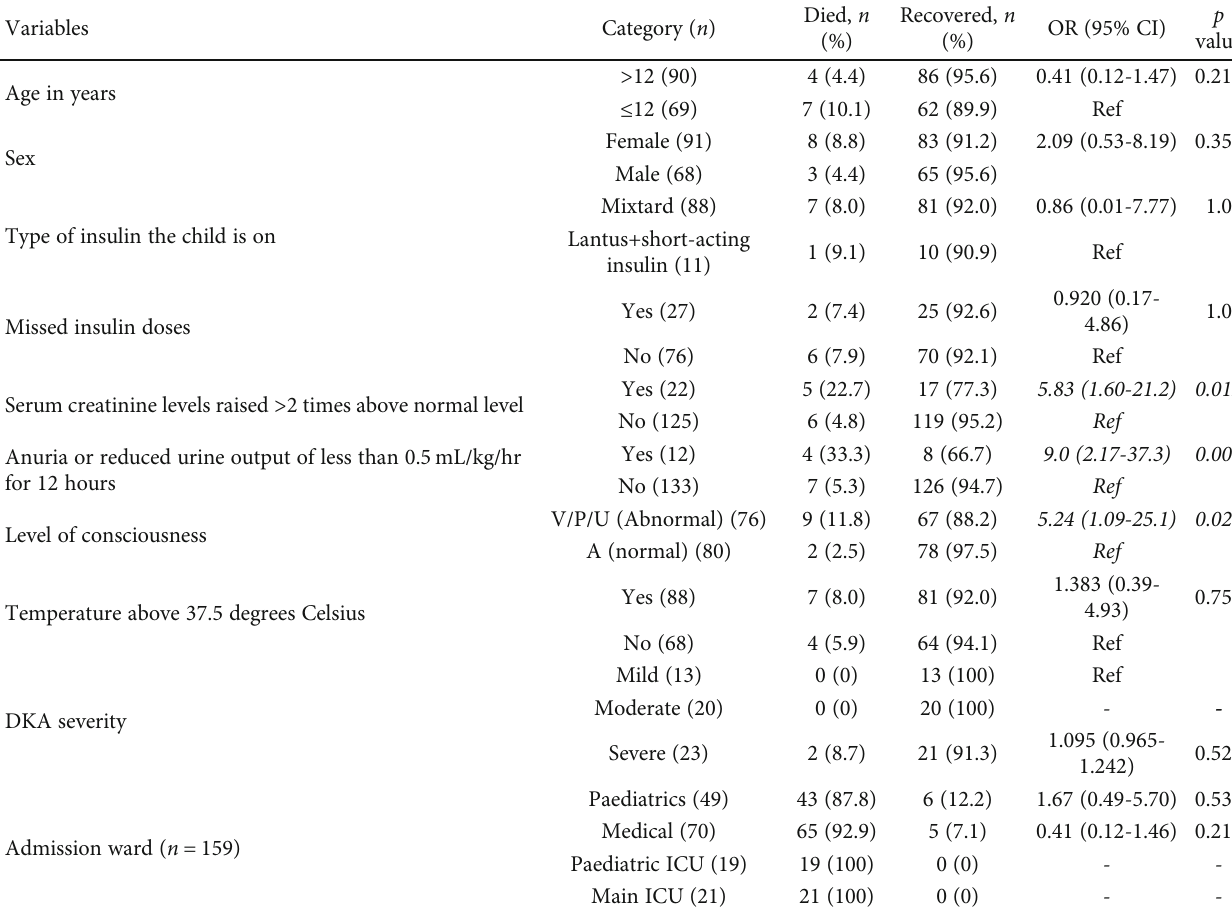
Table 2: Factors associated with mortality among children and adolescents with DKA.